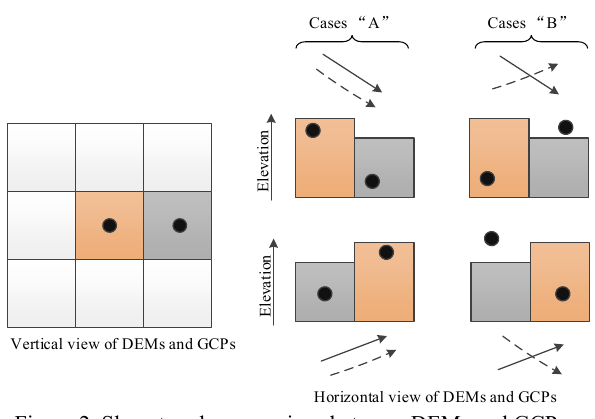
Figure 2. Slope trends comparison between DEMs and GCPs (Satge et al., 2016)